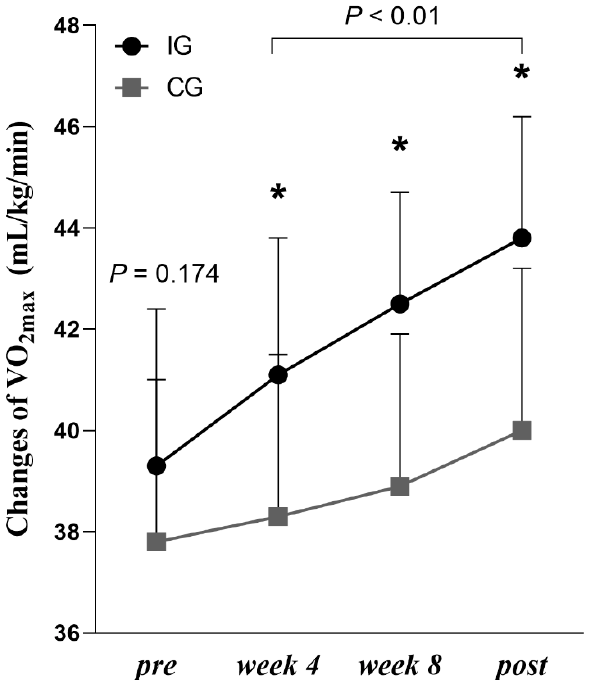
Figure 4. Differences of VO 2max between-group in IG and CG. * Denotes significant differences between IG vs. CG at level p < 0.05.